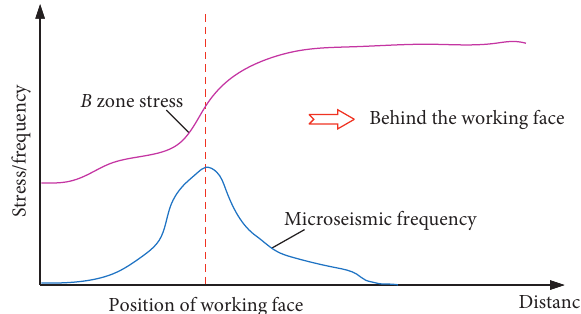
Figure 14: Distribution of stress and microseismic in the lateral coal-series strata along the